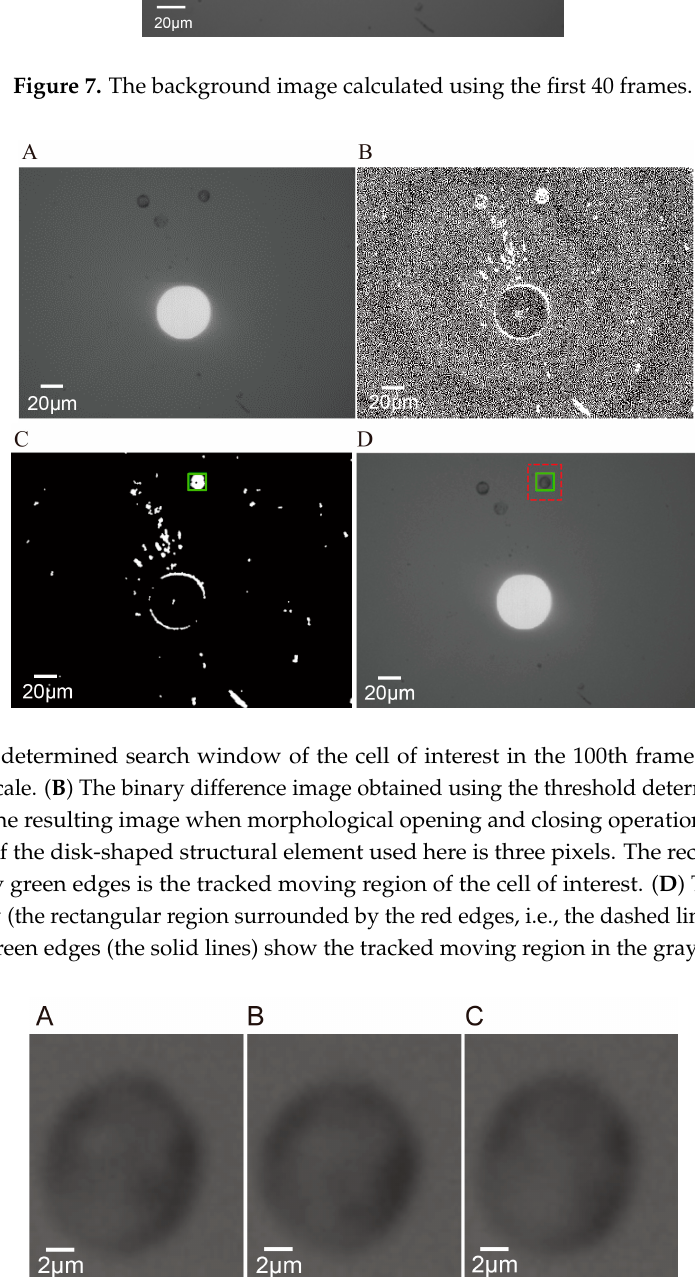
Figure 9. Regions of the cell of interest in the reference frame and adjacent frames. ( A ) The region in the reference frame. ( B ) The region tracked in the previous frame. ( C ) The region tracked in the subsequent frame.